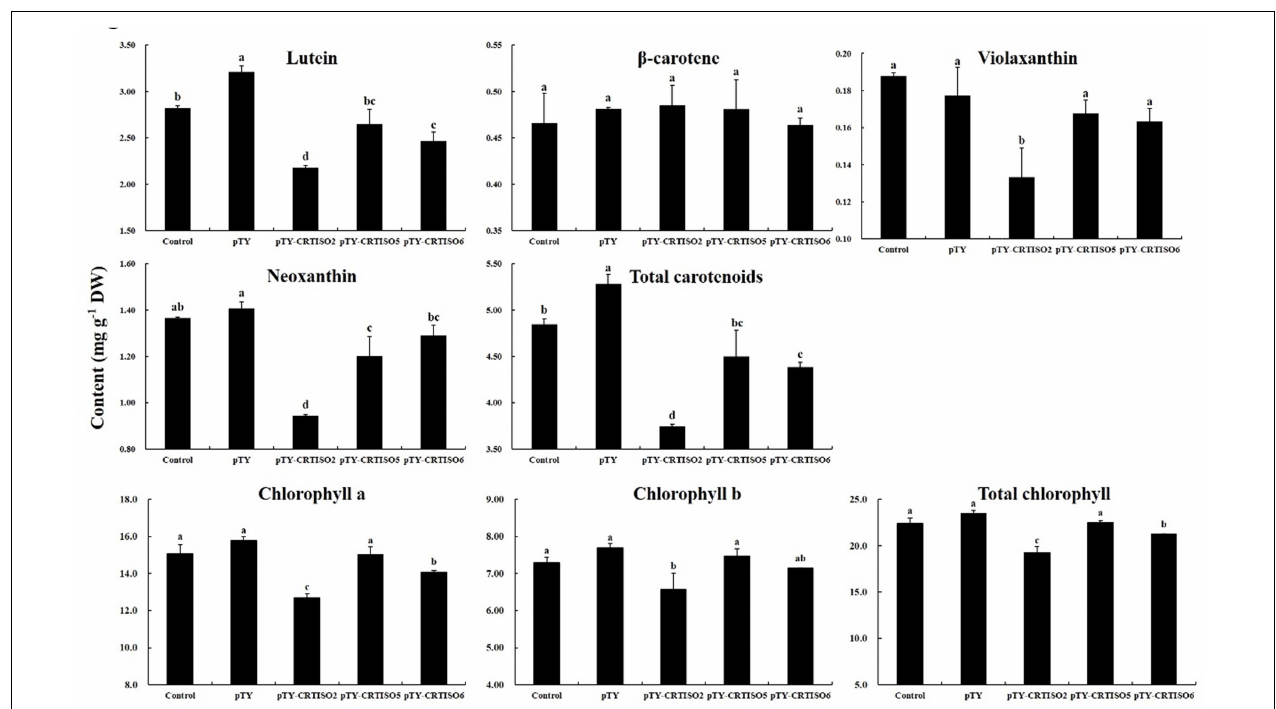
FIGURE 5 | Carotenoid composition and contents in control, pTY, and pTY-BoaCRTISO plants. Samples of leaves were taken from control, pTY, and pTY-BoaCRTISO plants at 1 week after the last infiltration. Data are expressed as mean ± standard deviation. The same letter in the same histogram indicates that there is no significant difference between the values tested by least significant difference (LSD) ( p <